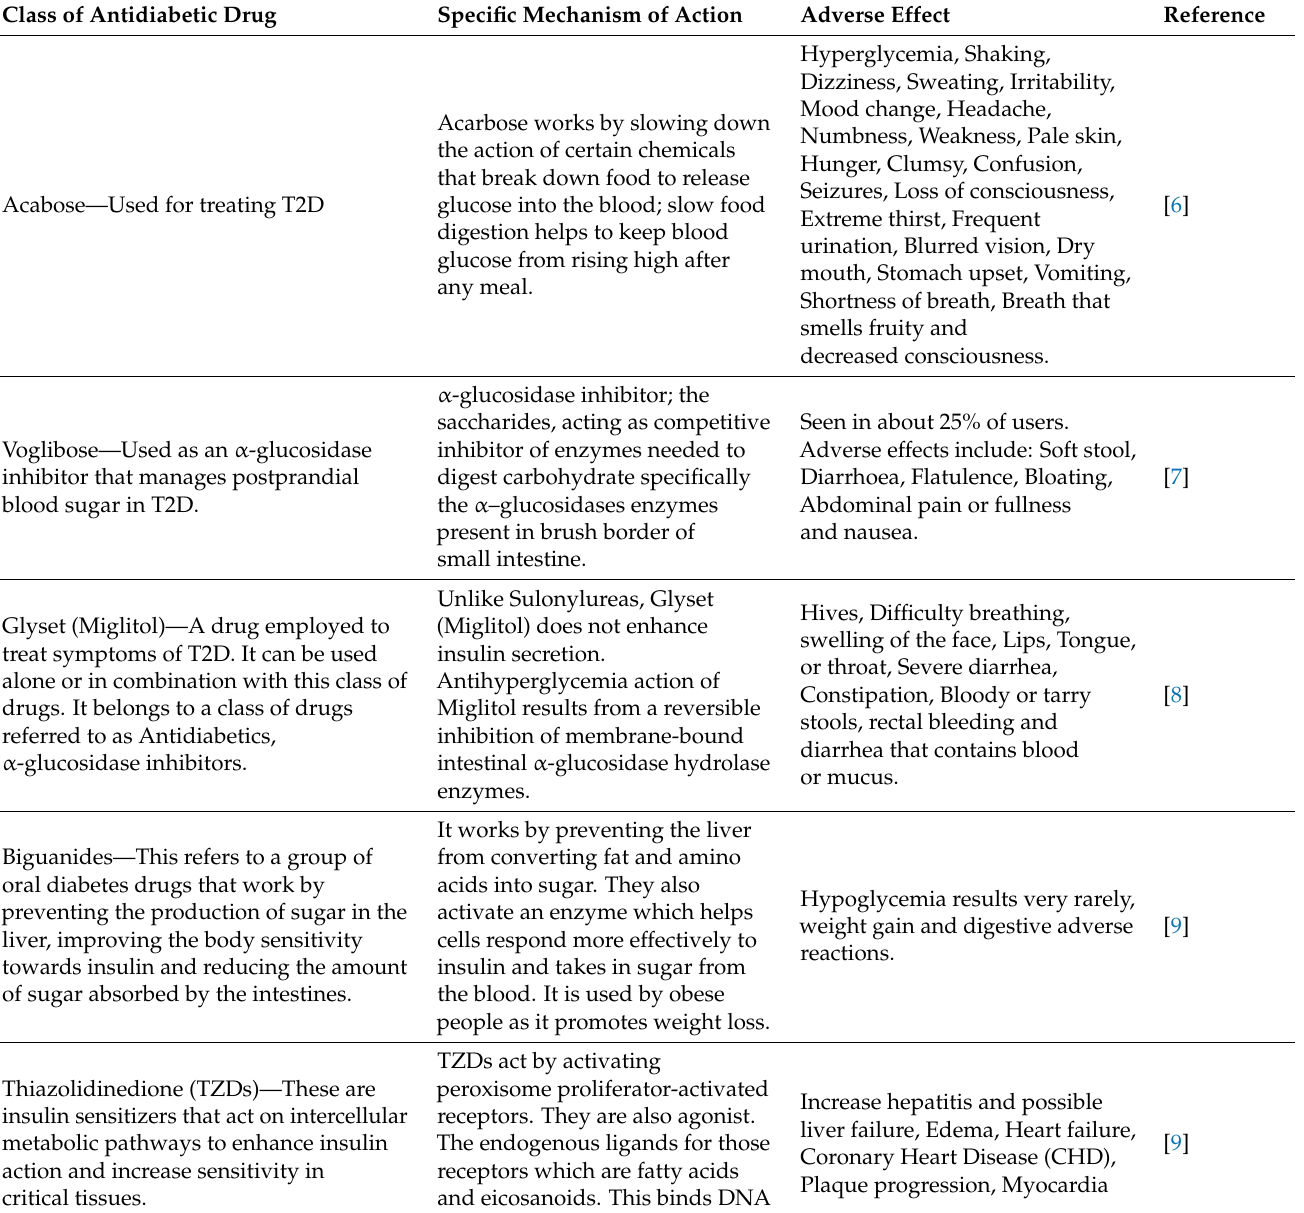
Table 1. Showing characteristics of common antidiabetic drugs used for T2D